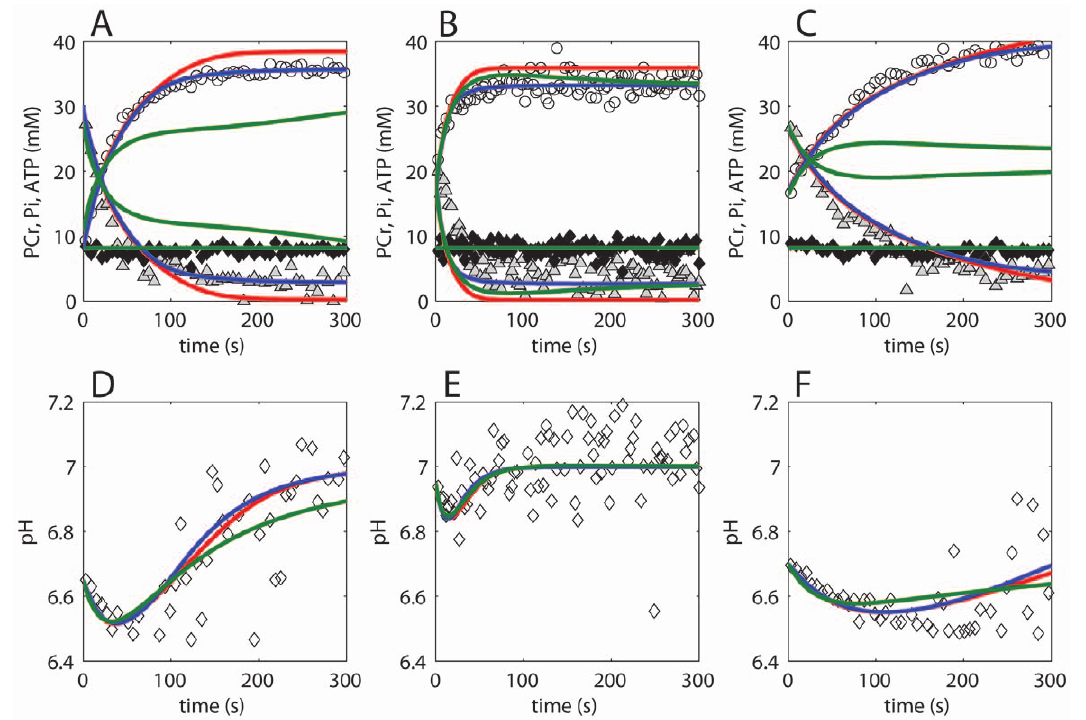
Figure 6. Model predictions versus 31 P MRS observed metabolite dynamics during post exercise recovery period. Experimental data and model simulations of a healthy control subject ( A,D ), athlete ( B,E ) and subject with a sedentary lifestyle ( C,F ) are shown. Model simulations according to the original model, model configuration i and model configuration ii are indicated by red, blue and green lines respectively. Experimental data of PCr, Pi, ATP and pH are indicated by open circles, grey triangles, closed diamonds and open diamonds respectively.